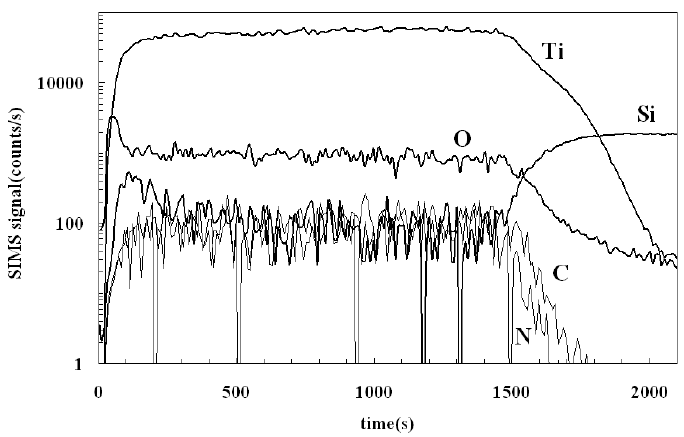
Figure 3. SIMS depth profiles of as ‐ deposited Ti films.